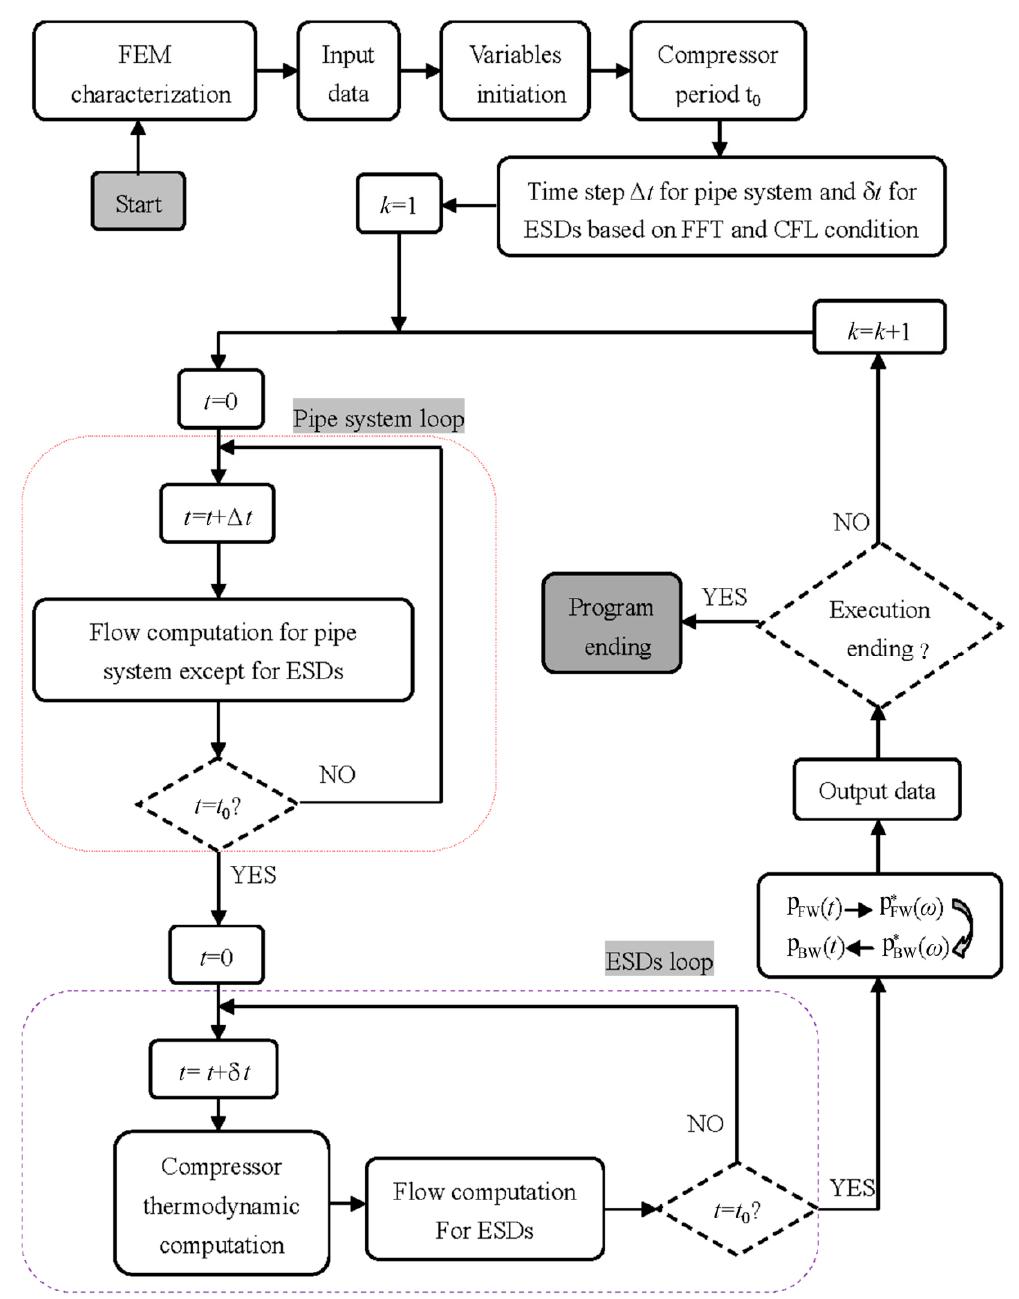
Figure 4. Flowchart of the hybrid model programme layout.